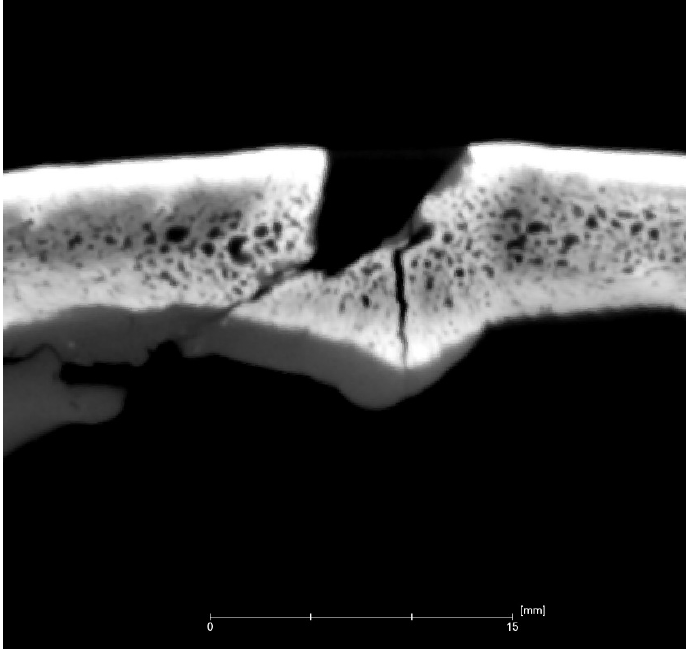
Figure 6. Vertical transverse slice of the cranial vault reflecting the shape of the weapon. The resolution is 190 μm.